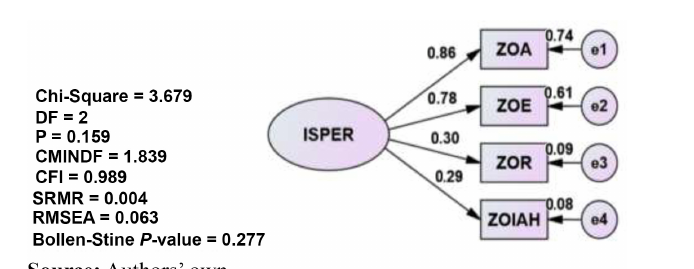
Figure 1. SFC model of ISPER – Model